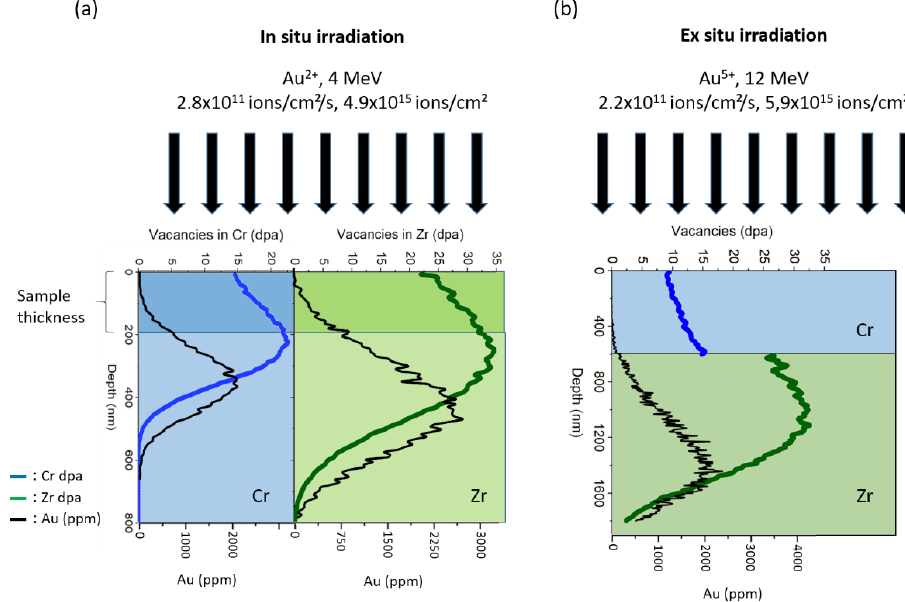
Figure 1. Depth profile of displacement damage under gold ion irradiation in: ( a ) in situ irradiation condition, ( b ) ex situ irradiation condition.